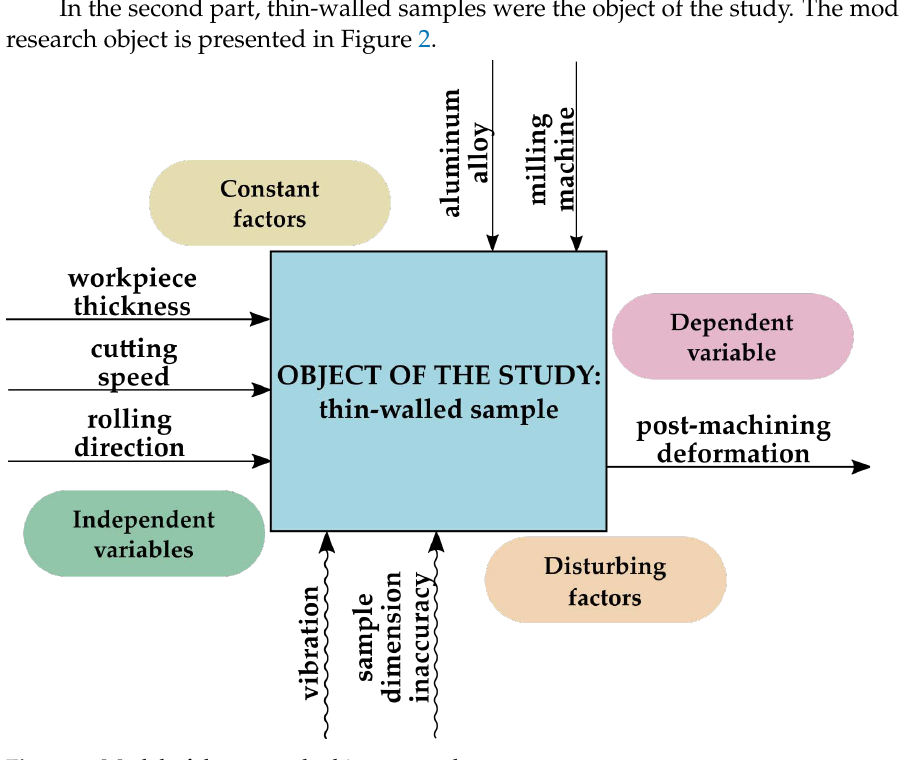
Figure 2. Model of the research object, second